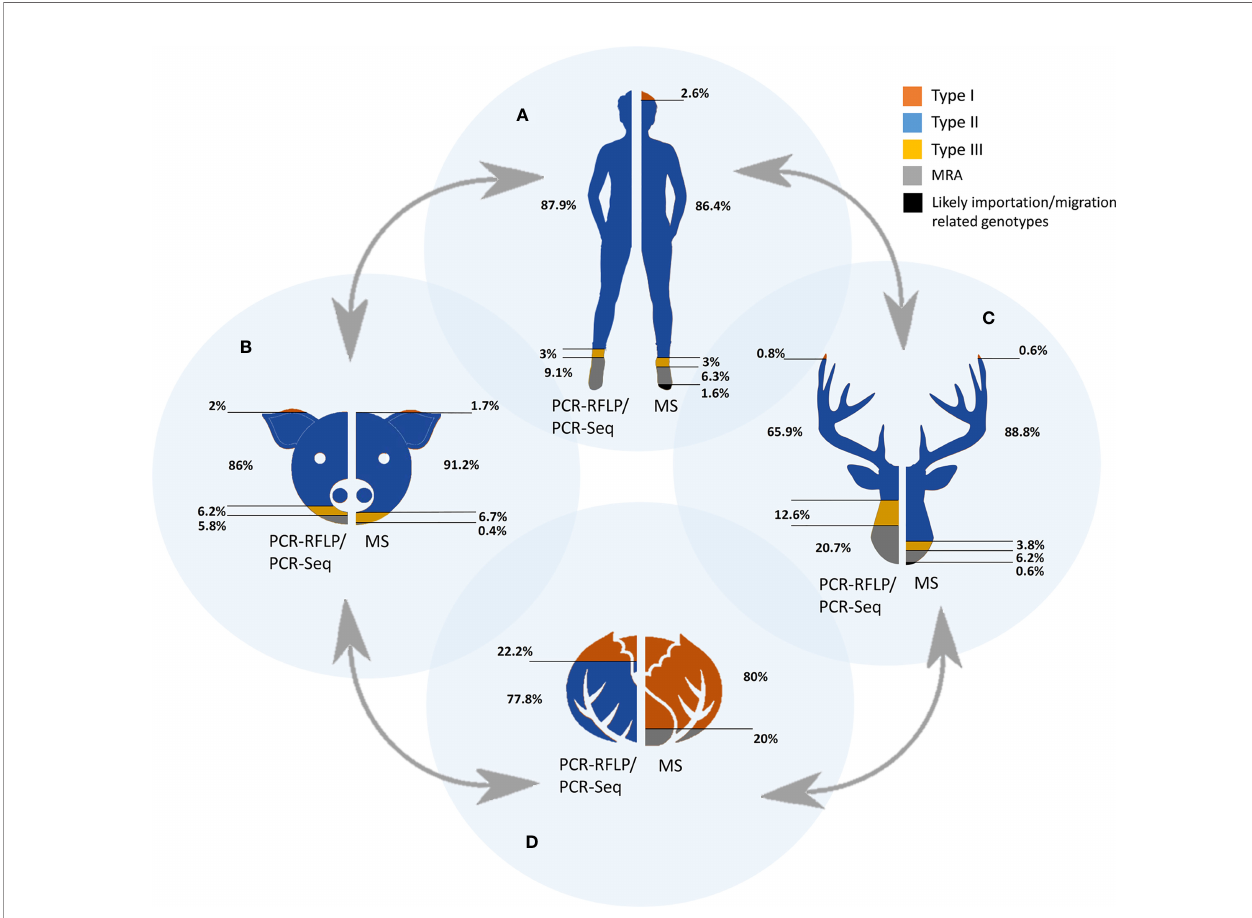
FIGURE 3 | Occurrence of Toxoplasma gondii genetic types by each of the One Health compartments. The four interconnected compartments comprised in the One Health concept are represented as humans (A) , domestic animals (B) , wild animals (C) and environment (D) . Colored areas represent the proportion of each genetic types detected either by PCR-RFLP/PCR-Seq or MS-typing. MRA: mixed infections, recombinant and atypical genotypes